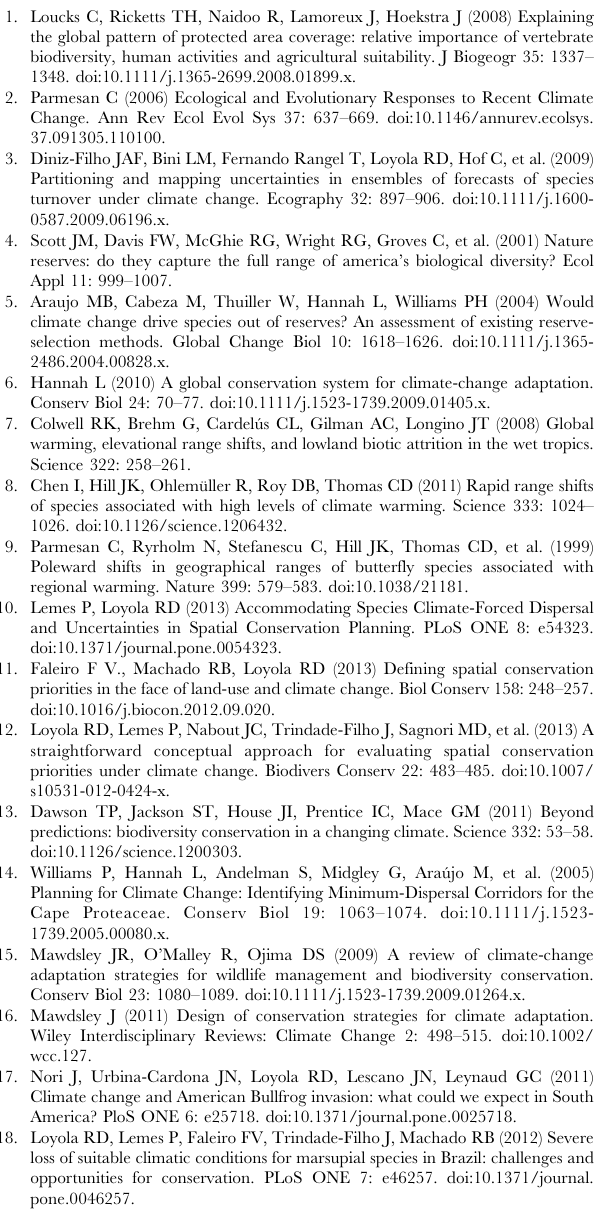
ecological niche modeling methods. Table S4 Turnover measures for each of 11,464 grid cells overlaying the Atlantic Forest, Brazil, in this study. Turnover is shown for each modeling method (Euclidian and Gower distance, ENFA, MaxEnt, GARP, and Artificial Neural Networks), and climate model (CCCMA-CGCM, CSIRO-MK2, and HCCPR- HadCM3). Turnover found across the ensemble of distance and machine learning methods are also